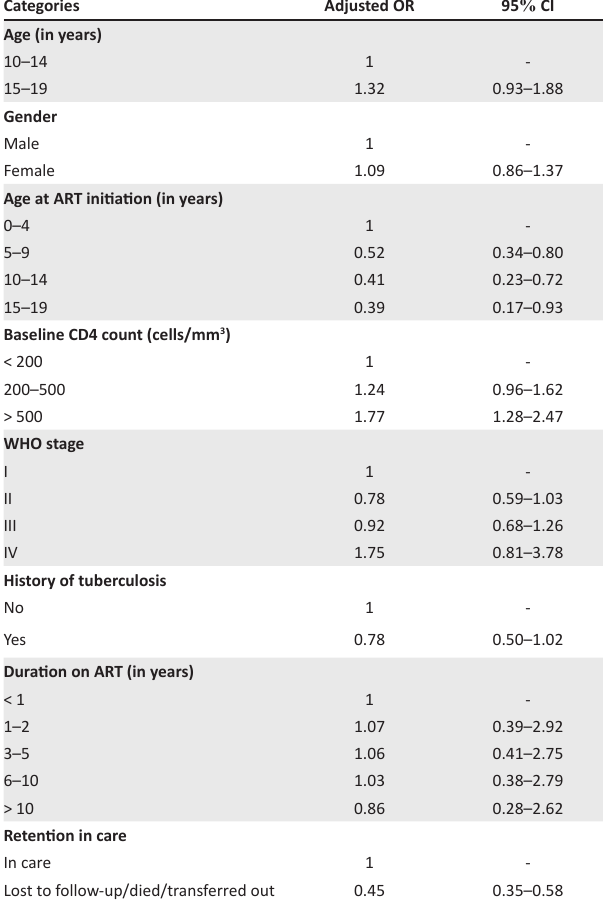
TABLE 2: Determinants of viral non-suppression (≥1000 RNA copies/mL) among adolescents on ART in the Thabo Mofutsanyane District, Free State province, 2019 ( N =